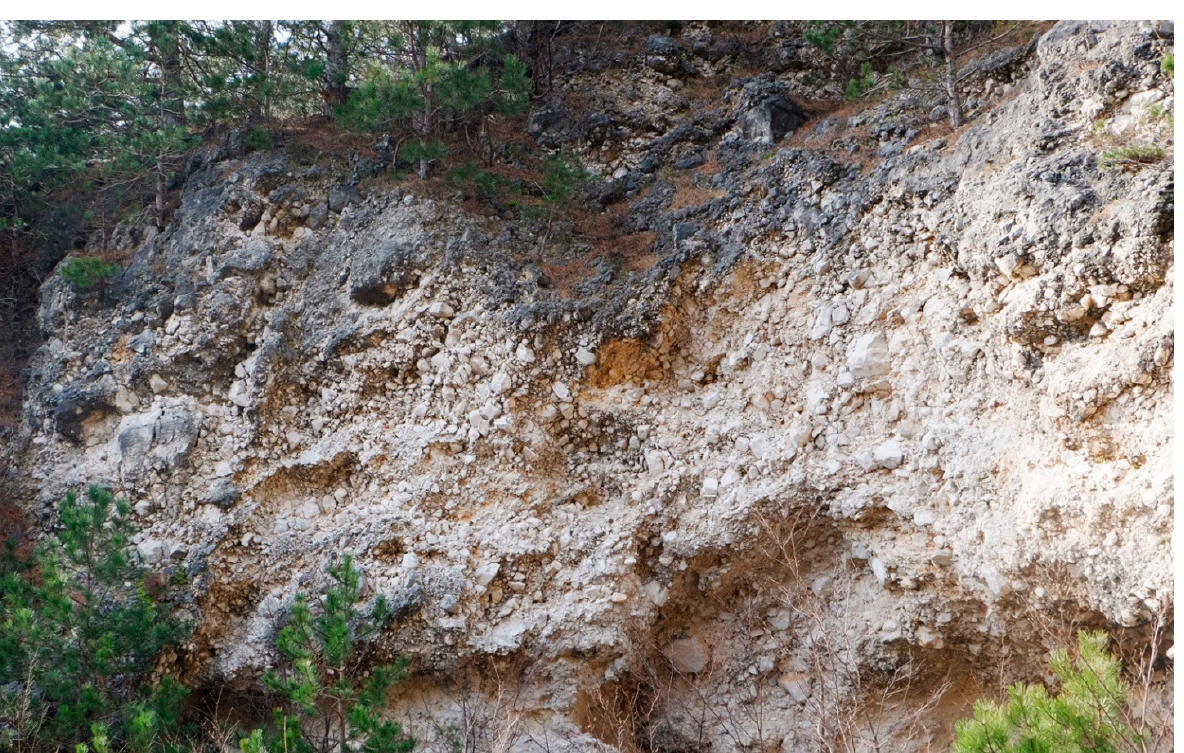
Figure 4. Geomorphometric elements of sedimentary bodies: ( A ) Podrta gora fossil rock avalanche; ( B ) Gradiška gmajna fossil rock avalanche; and ( C ) Stara baba, Veliki strel, and Klapa č iše carbonate blocks, based on the classification of the schematic representation of the landslide. Adapted from [46–48].